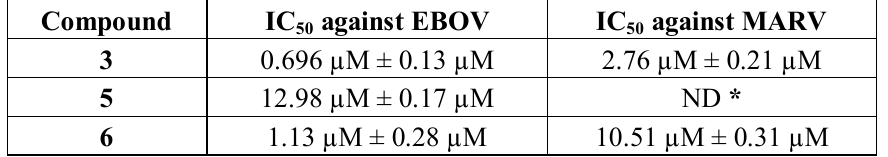
values against Ebola (EBOV) and Marburg (MARV) cellular Table 1. IC 50